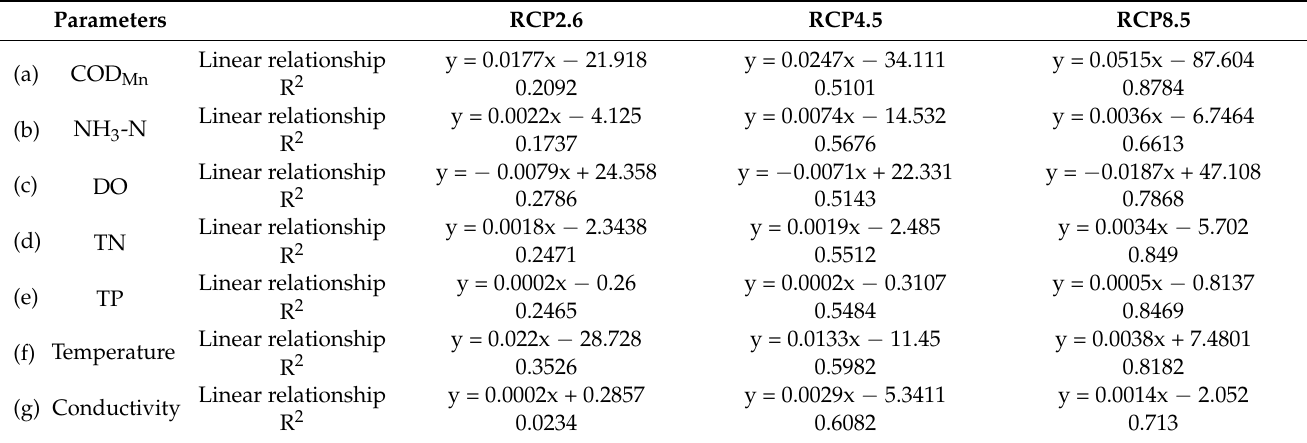
Figure 6. Trends in chemical and physical parameters in wetland water from 2022 to 2100 under three RCP scenarios; ( a ) COD Mn (mg/L); ( b ) NH 3 -N (mg/L); ( c ) DO (mg/L); ( d ) TN (mg/L); ( e ) TP (mg/L); ( f ) Temperature (°C); ( g ) Conductivity (mS/m). Table 8. Linear relationship of chemical and physical parameters in wetland water under three RCPs scenarios from 2022 to 2100.